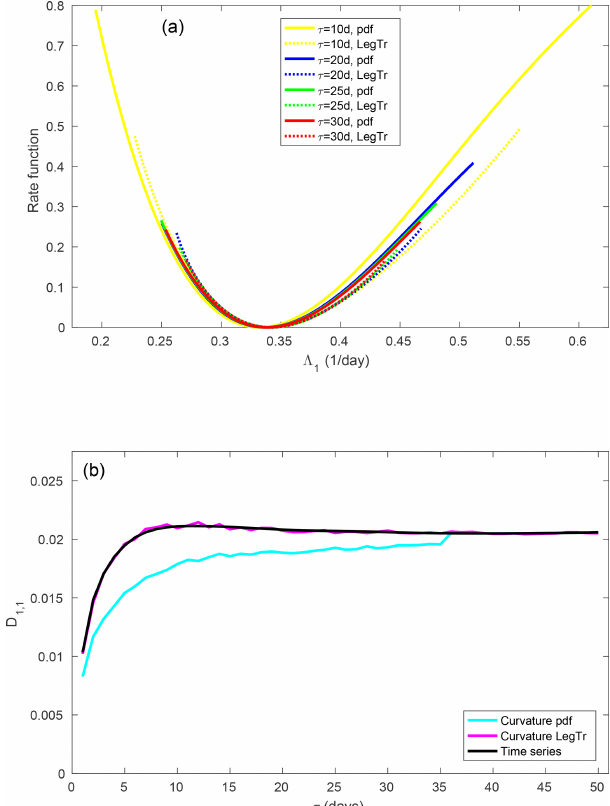
Figure 7. (a) Large-deviation rate function of the first FTLE. (b) El- ement D 1 , 1 of the diffusion